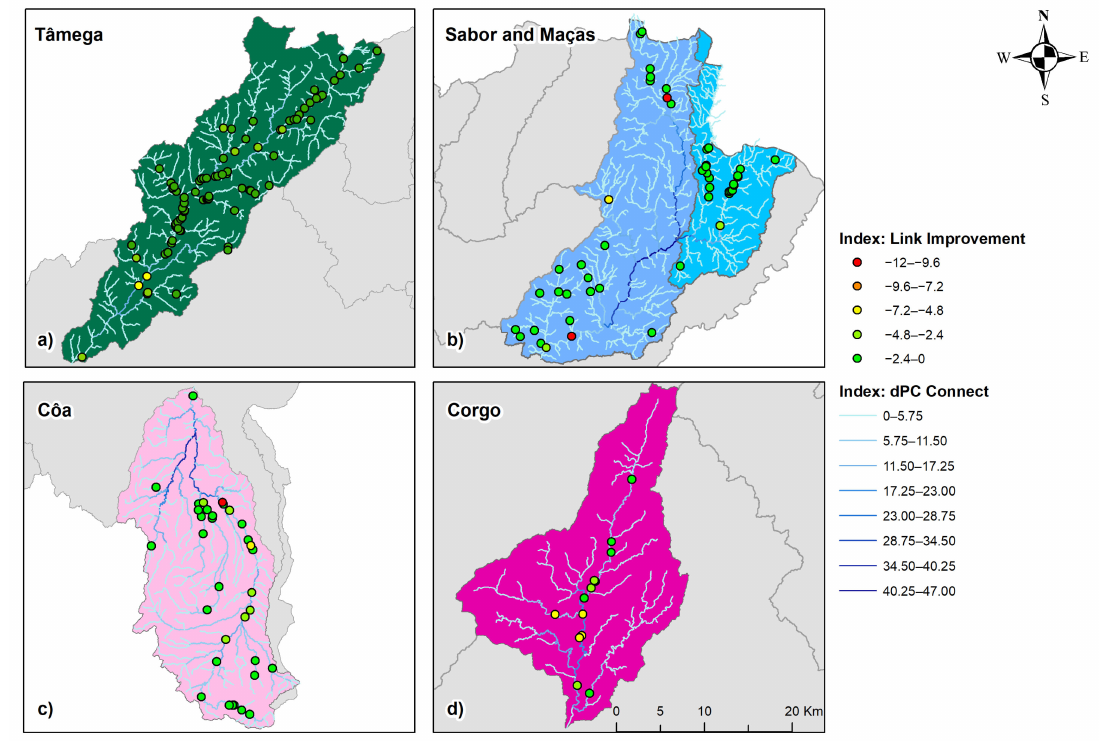
Figure 5. Spatial distribution of connectivity indices dPC connector and link improvement, within the tested sub-basins: ( a ) T â mega River Basin; ( b ) Sabor River Basin; ( c ) C ô a River Basin; ( d ) Corgo River Basin (on a different scale to the others). Table 3. Distribution of dams and weirs per link improvement classes (confirm ranges in Figure